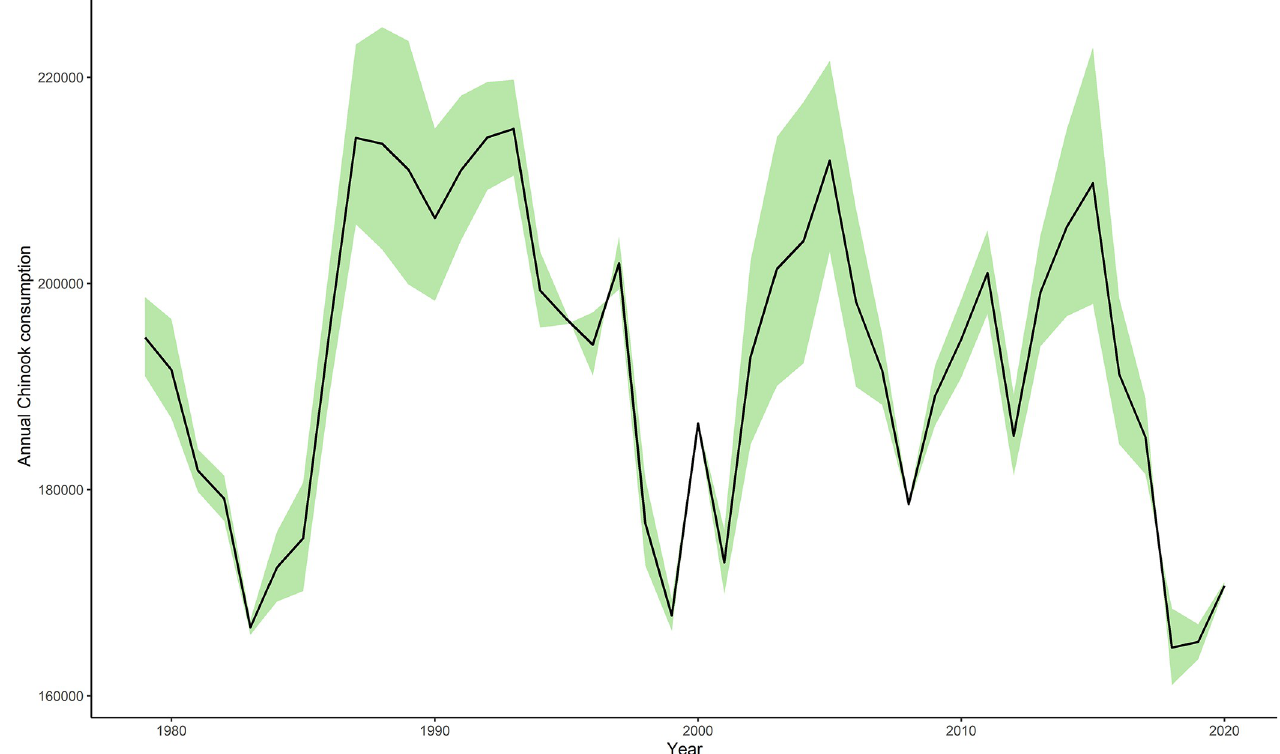
Fig 4. Estimated annual (excluding November-March) consumption of Chinook salmon (in number of fish) from April to October in the SRKW range from 1979 to 2020. The black line represents the predicted annual Chinook salmon consumption for T Chinook salmon consumption for T s = 5h ±